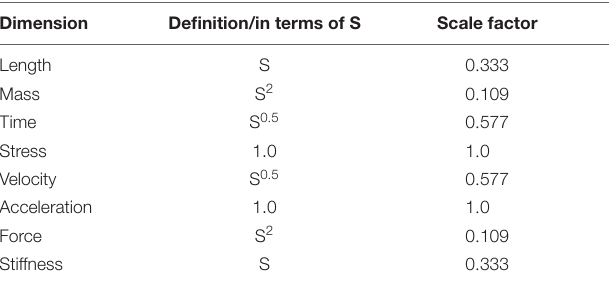
TABLE 1 | Scale Factors between the prototype and scale models.